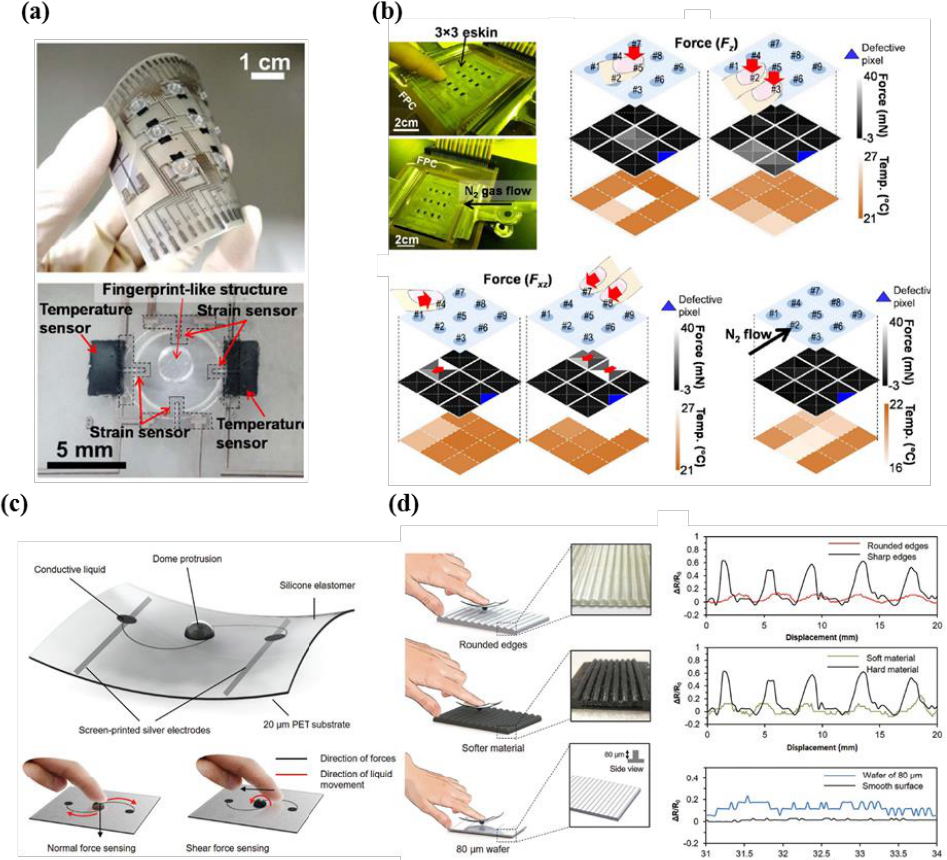
Figure 7. ( a ) Photograph showing the fully fabricated sensor with 3 × 3 array (top) and unit cell (bottom); ( b ) real applications of the device using normal force, shear force, and N 2 flow (reprinted with permission for Figure 7a,b from Ref. [67] Copyright 2014 American Chemical Society); ( c ) schematic illustration demonstrating the unit cell of the flexible microfluidic tactile sensor, and working principle; ( d ) illustration of texture sensing experiment and related output performances (rounded edges, softer material, and 80 µ m) (reprinted with permission for Figure 7c,d from Ref. [72] Copyright 2017 John Wiley and